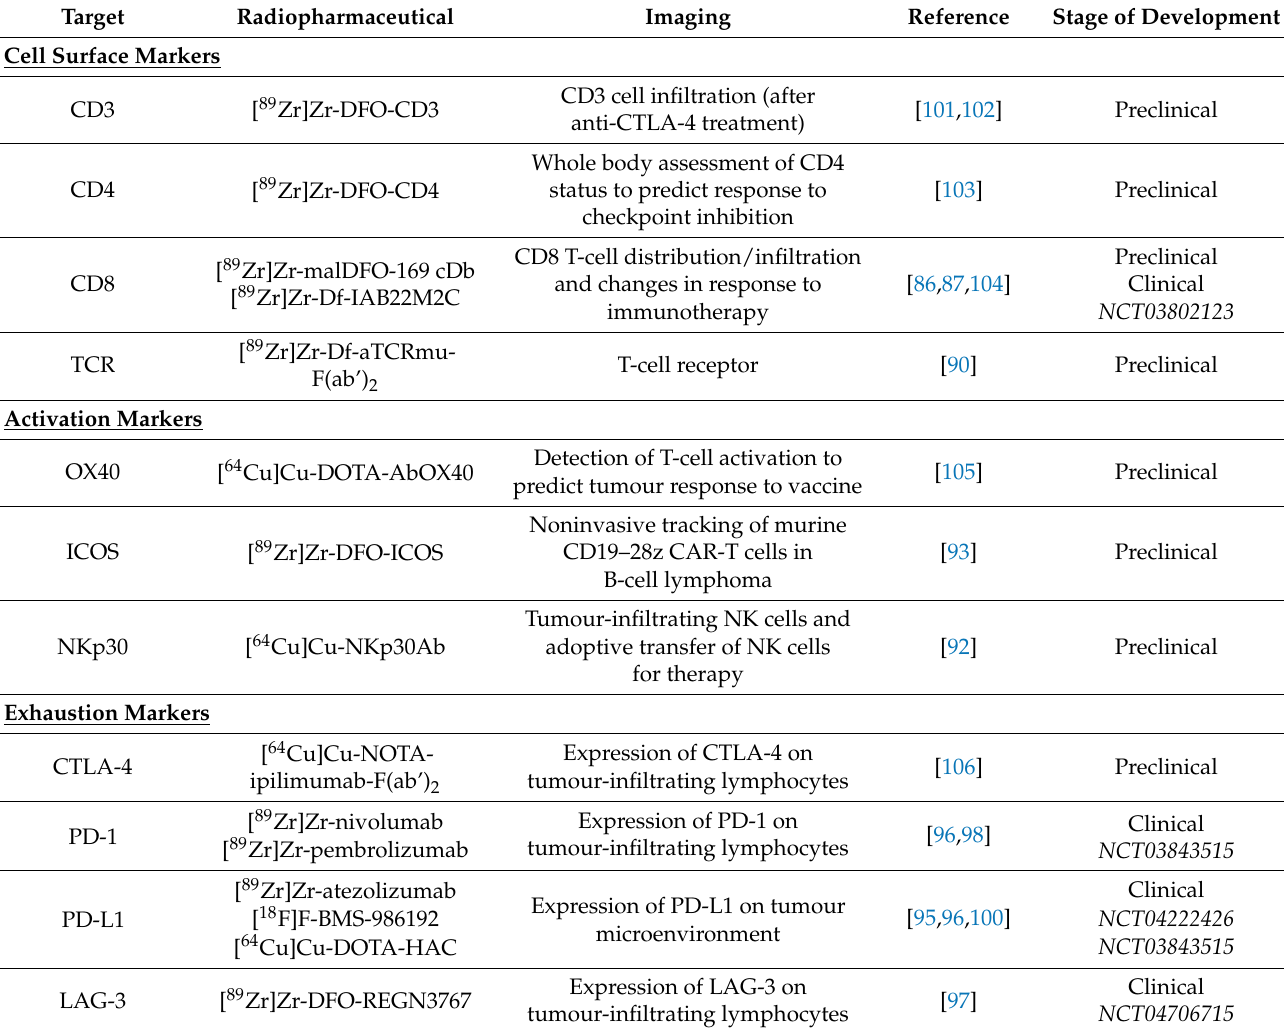
Table 3. Tracking therapeutic cell location and functional status using radiolabelled